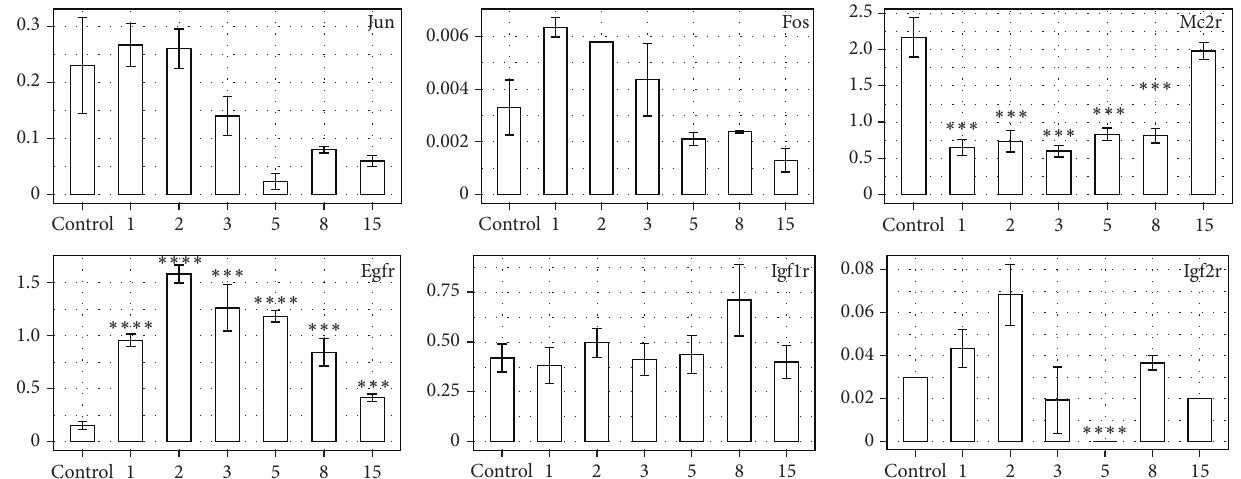
Figure 6: QPCR assay of Junb, Fos, Egfr, Igf1r, Igf2r, and Mc2r mRNA expression in the regenerating rat adrenal cortex compared to control adrenals. Bars represent mean ± SEM ( 𝑛 = 3 ). All samples were amplified in triplicate, and HPRT gene expression was used as reference to normalize data. Statistically significant differences in relation to control group: ∗ 𝑃 < 0.05 ; ∗∗ 𝑃 < 0.02 ; ∗∗∗ 𝑃 < 0.01 ; ∗∗∗∗ 𝑃 < 0.001 .